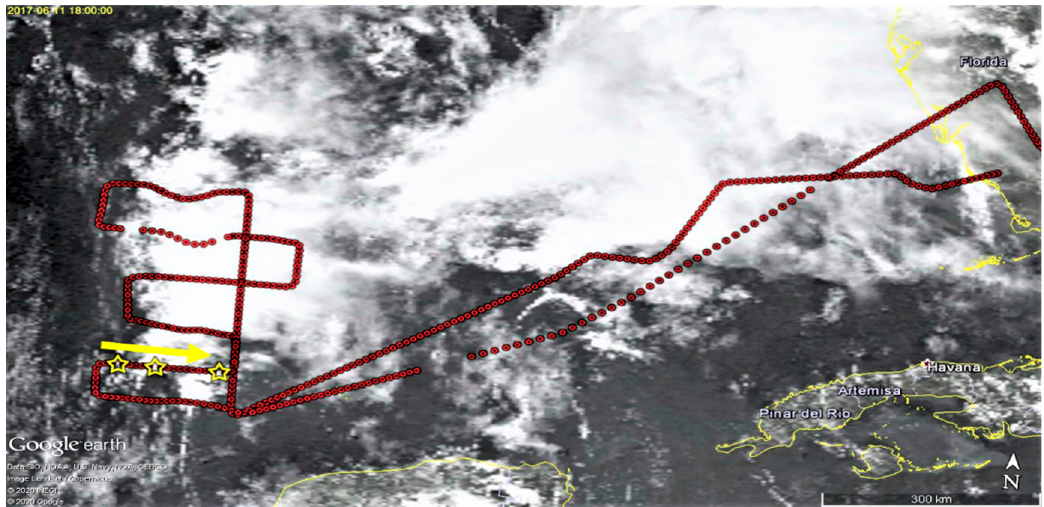
Figure 23. DC-8 and DAWN flight track investigating organized convection on 11 June 2017 with GOES13 VIS imagery at 1800Z near the time of the selected profiles (gold star) in the inflow region (Google Earth).